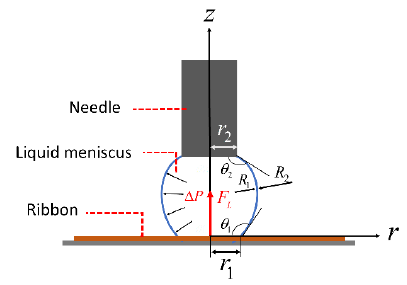
Figure 2. Force illustration of lifting a ribbon.